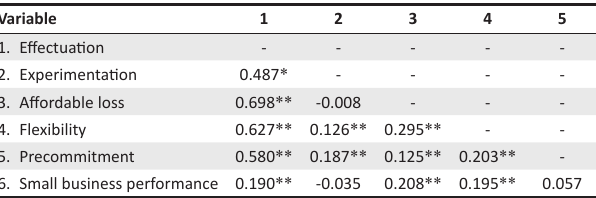
TABLE 1: Pearson correlations. Variable